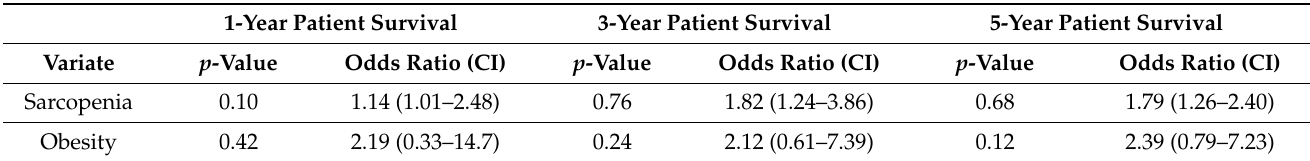
Table 6. Cox regression analysis of 1-year, 3-year and 5-year patient survival with cutoff values for sarcopenia and obesity. CI = confidence interval.